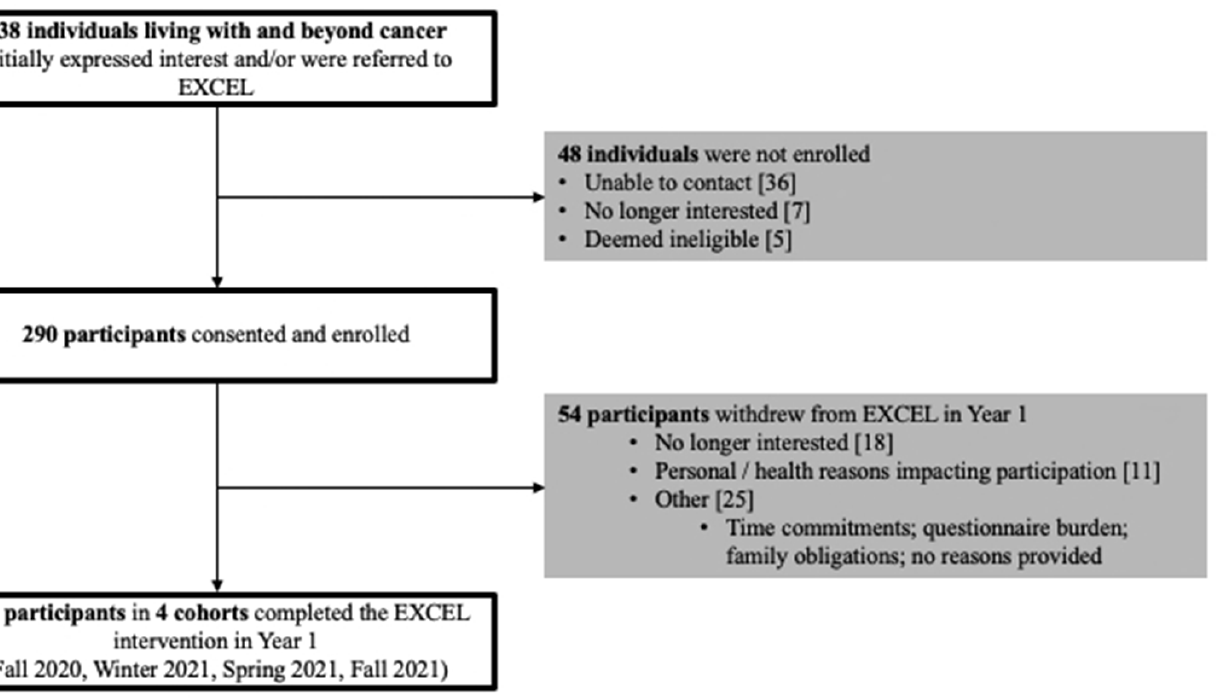
Figure 3. ( A – C ): EXCEL regional HCP networks.